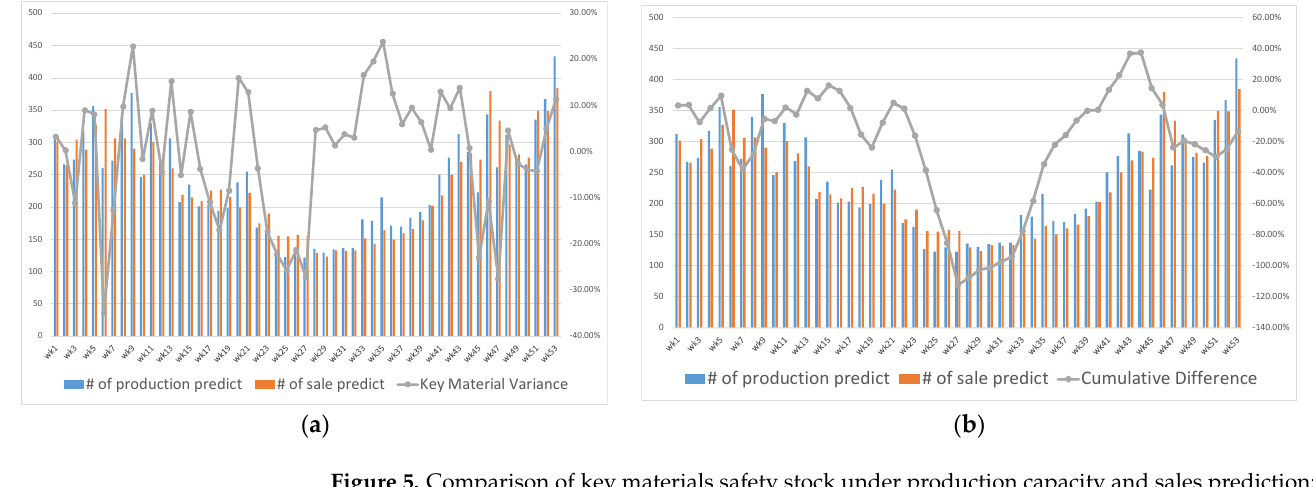
Figure 5. Comparison of key materials safety stock under production capacity and sales prediction: ( a ) Difference between estimated production capacity estimates and sales prediction; ( b ) Accumulation of the difference between production capacity estimates and sales prediction.